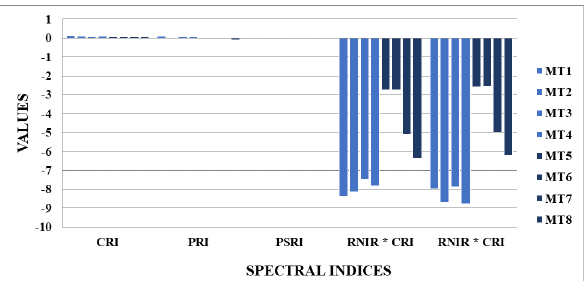
Figure 10.Comparison of different spectral indices for